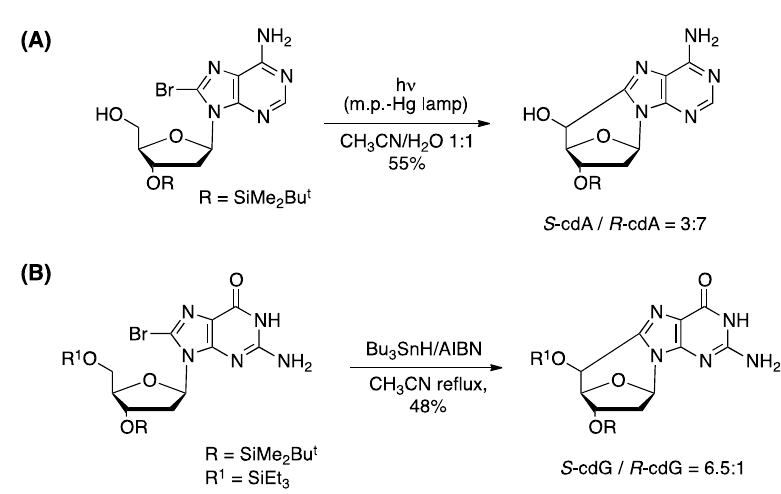
Figure 4. Synthesis of ( A ) 5 ′ ,8-cyclo-2 ′ -deoxyadenosine (cdA) and ( B ) 5 ′ ,8-cyclo-2 ′ -deoxyguanosine (cdG) in both diastereoisomeric forms, differentiating the two secondary 3’OH and 5’OH groups, by the radical cascade protocol. (m.p.: medium pressure).